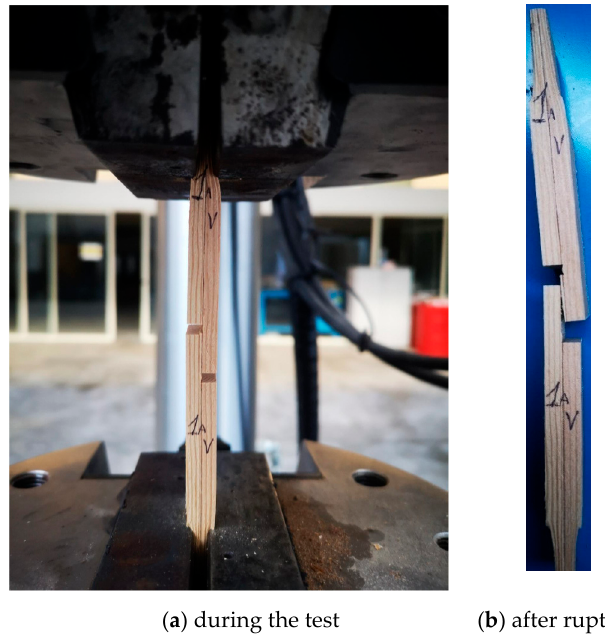
Figure 6. Lap joint test. ( a ) during the test, ( b ) after rupture. For each specimen, the test results were represented by a force-displacement graph (Figure 7). 0.00.51.01.52.02.5 Figure 7. Typical force-displacement graph of a lap joint test (TSMA01). For each specimen, the mean shear stress, τ (cid:3364) , was calculated in accordance with UNI EN 302-1 [30] as τ (cid:3364) = F max /A , w here F max is the applied load at failure and A is the bonded surface area. Furthermore, the shear modulus, G, for the adhesive layer was calculated as follows: